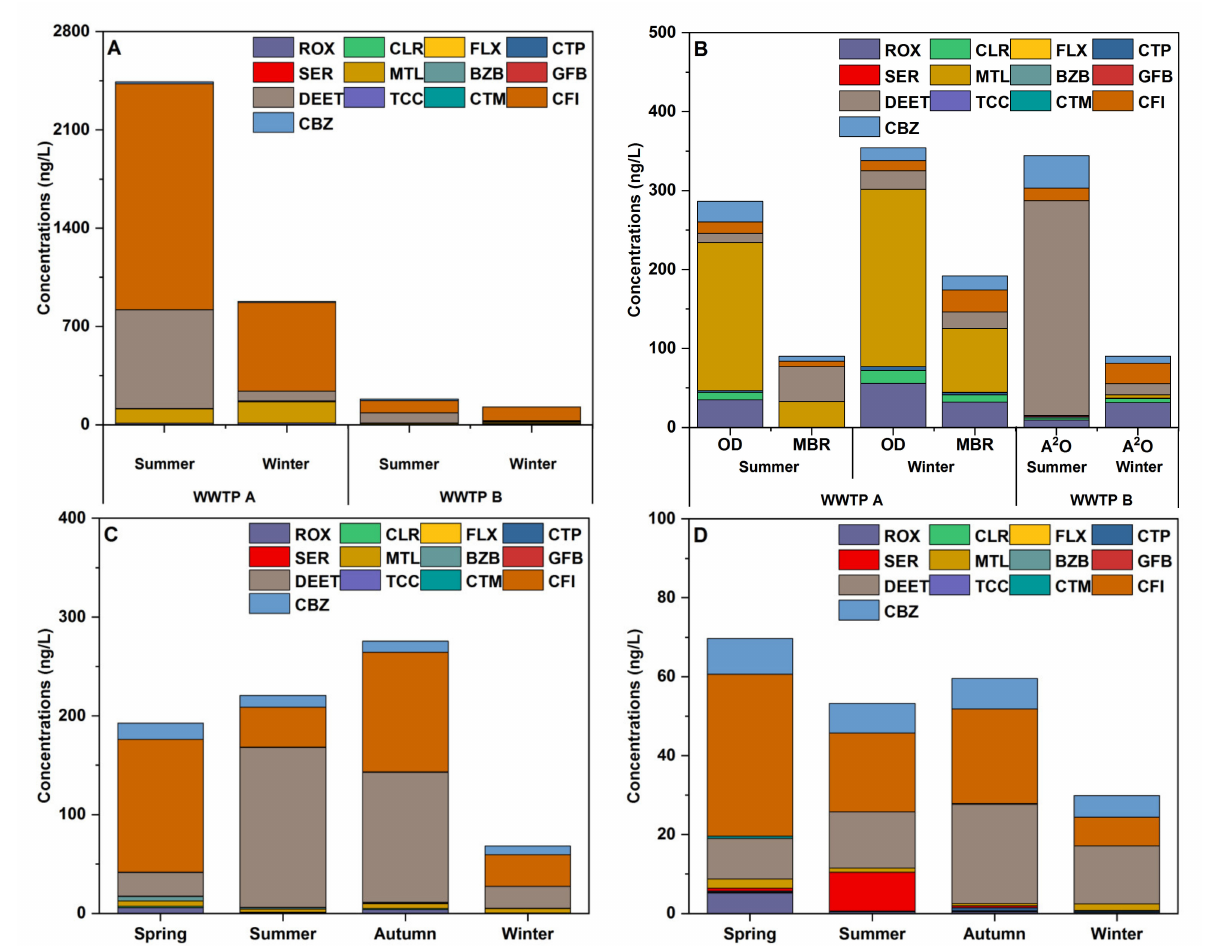
Figure 2. Seasonal variations in the concentrations of PPCPs in the wastewater ( A ) influents and ( B ) effluents, ( C ) river networks, and ( D ) Taihu